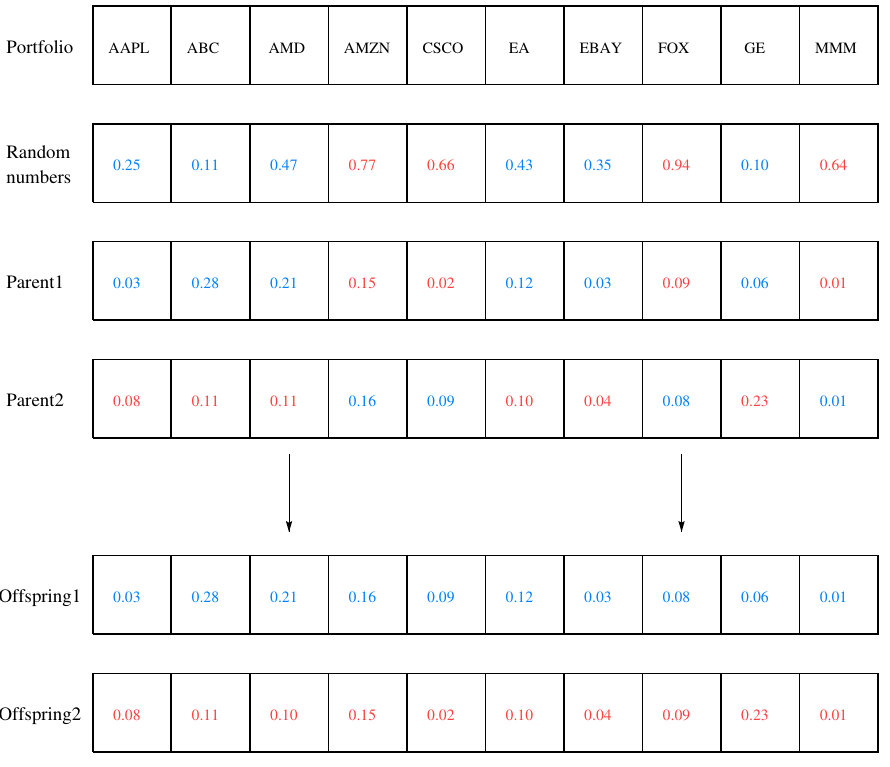
Figure 1. Example of a uniform crossover. Each gene was randomly selected from one of the corresponding genes of the parents. If a random number is less than 0.5, Offspring 1 inherits a gene from Parent 1; otherwise, it inherits a gene from Parent 2. Offspring 2 inherits genes from the opposite parent of Offspring